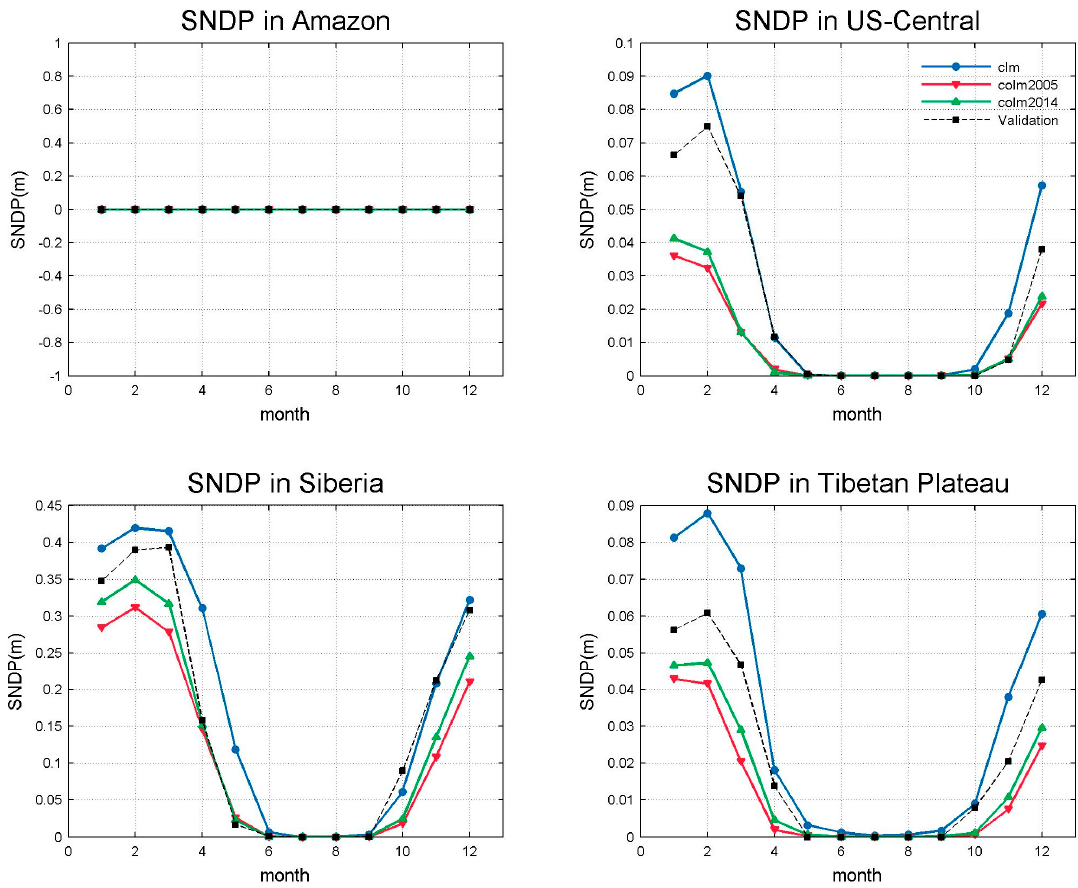
Figure 6. Same as Figure 3, but for snow depth (Units: m). Table 3. Statistical summary of simulated snow depth annual cycles.